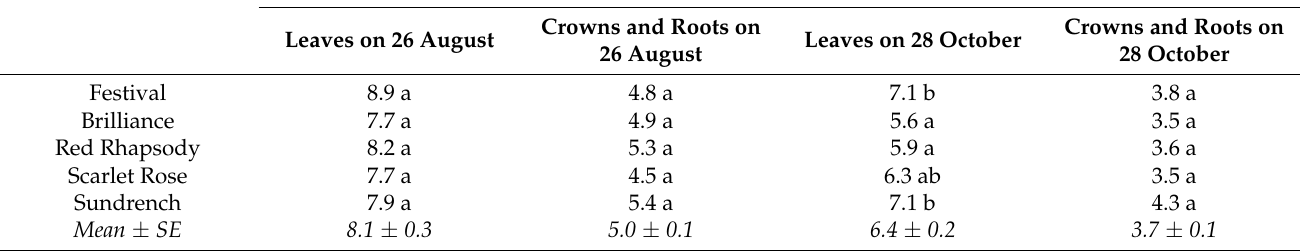
Table 3. Variations in the concentration of non-structural carbohydrates in the leaves, crowns, and roots in five strawberry cultivars in Queensland. The plants were harvested on 26 August or on 28 October. Data are the means of six replicates per cultivar. Means in a column followed by a common letter are not significantly different by the Fisher’s least significant test at 5% level of significance. Means ± (SE or standard error) across all the cultivars for each harvest also presented. DW = dry